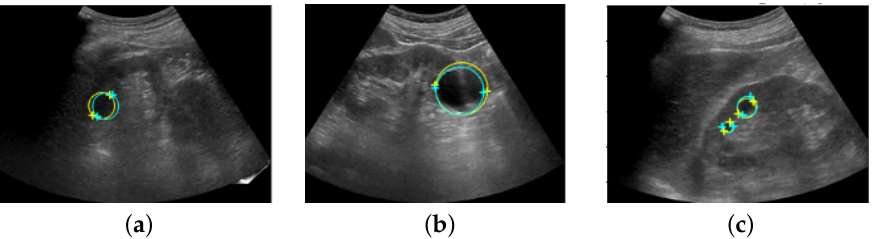
Figure 8. Ultrasound images with salient landmarks placed by sonographers and placed at coor- dinates predicted by the automated system. The yellow crosses are the coordinates of the salient landmarks placed by Sonographer 1 and the light blue crosses are the coordinates predicted by the automation system. Renal cysts are approximated by a circle with a diameter that is a straight line connecting the two points of salient landmarks. Yellow corresponds to placement by Sonographer 1 and light blue corresponds to prediction by the automated system. ( a , b ) show detection of a single renal cyst. ( c ) shows detection of two renal cysts.